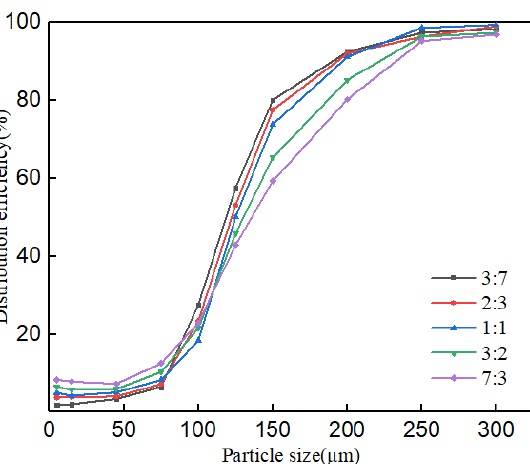
Figure 13. Effect of the mud – sand mixing ratio on classification efficiency.